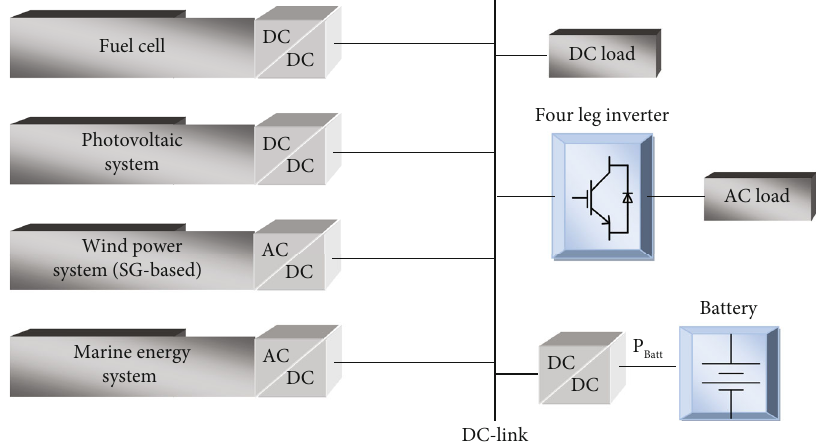
Figure 1: The schematic of a typical renewable energy-based hybrid power